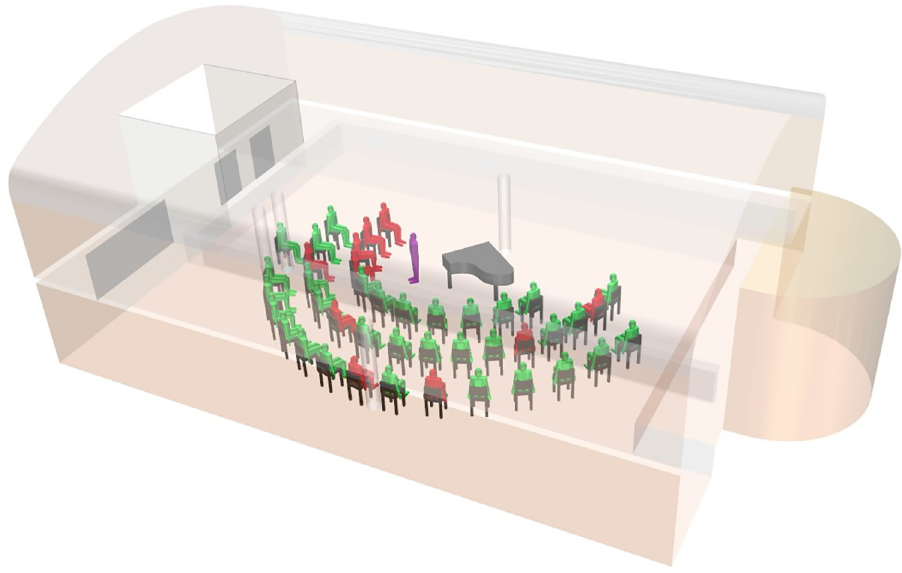
Fig 3. Room model of choir 2, Berlin, 12 March 2020. Presumable primary case displayed in purple, members with laboratory-confirmed SARS-CoV-2-infection in red, members with negative SARS-CoV-2 serostatus or without symptoms in green, standing person = conductor. Note: The seating order and distances are not identical to that of the actual rehearsal, but reconstruct the distribution of cases and non-cases in the room.